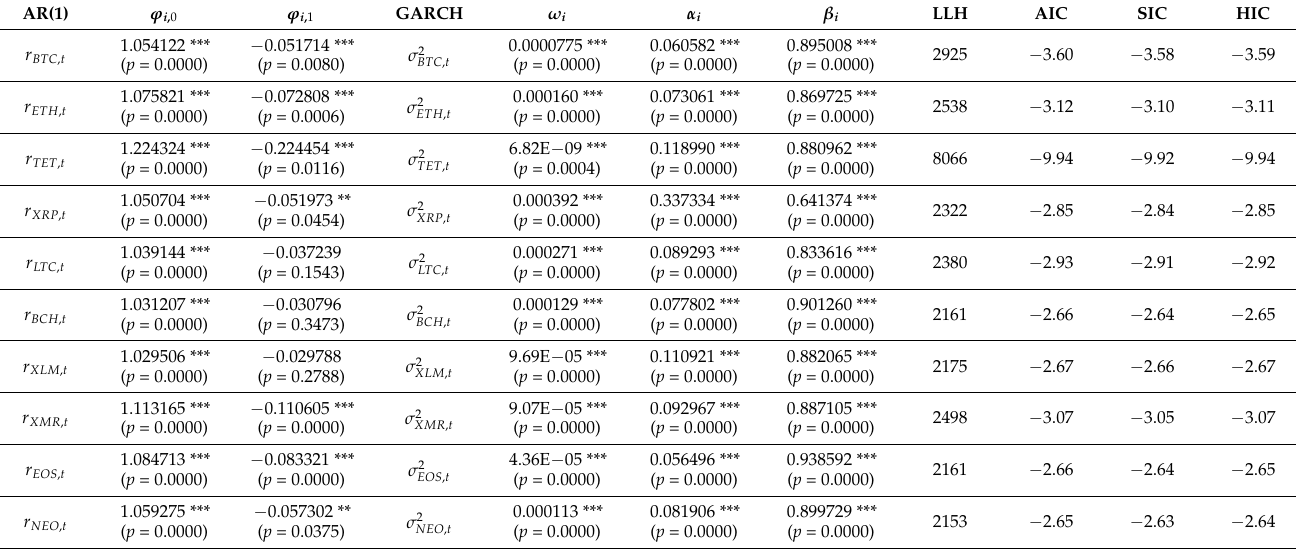
Table 8. Regression models of AR(1) and GARCH(1,1) for the 10 cryptocurrencies’ return indices during the full